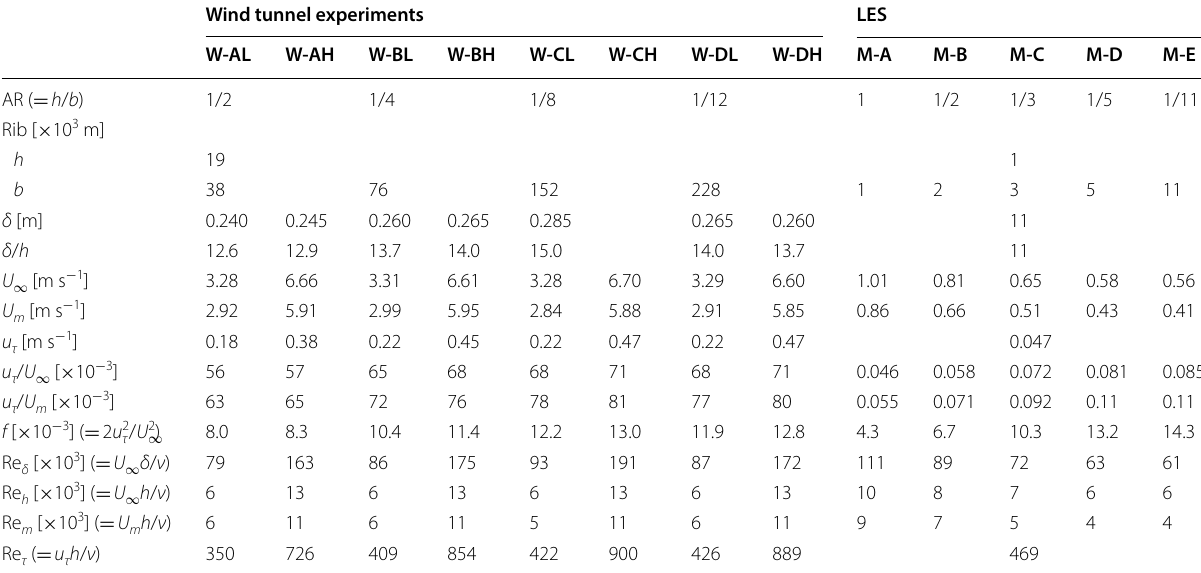
Table 1 Configuration of the flows over hypothetical urban areas in wind tunnel experiments and LES Wind tunnel